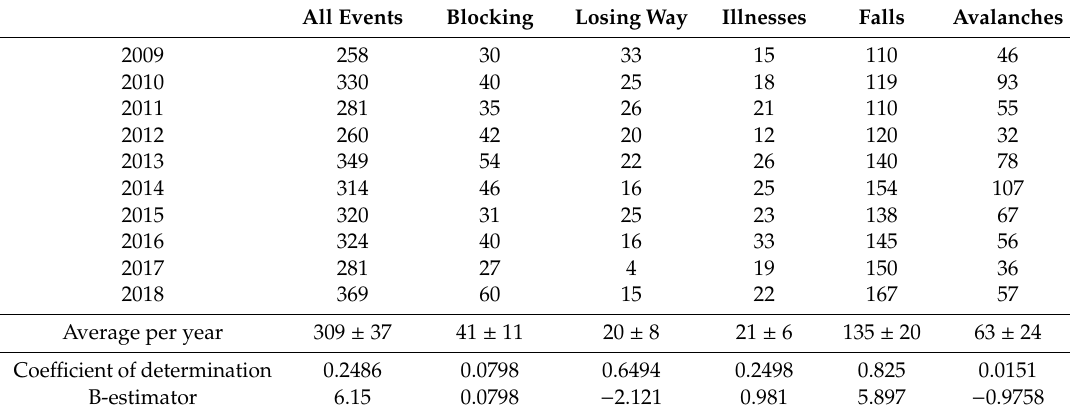
Figure 1. Causes of mountain emergencies in backcountry skiing (absolute and relative frequencies for the total sample and separated for female and male). Table 2. Events per subcategory and calendar year over the 2009–2018 period.